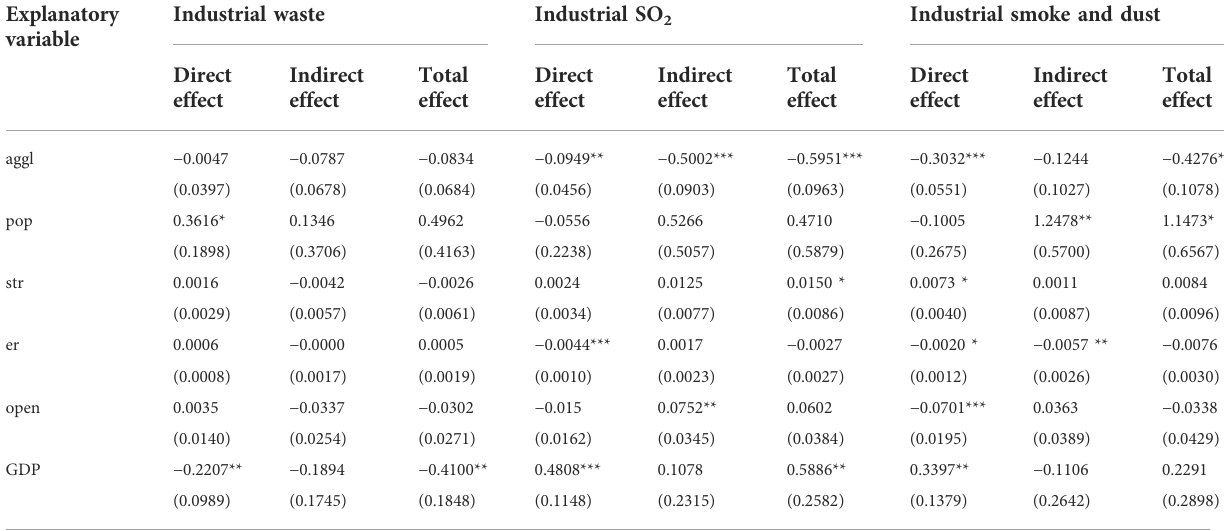
TABLE 3 Regression results of the impact of industrial agglomeration on industrial pollution in the Yellow River